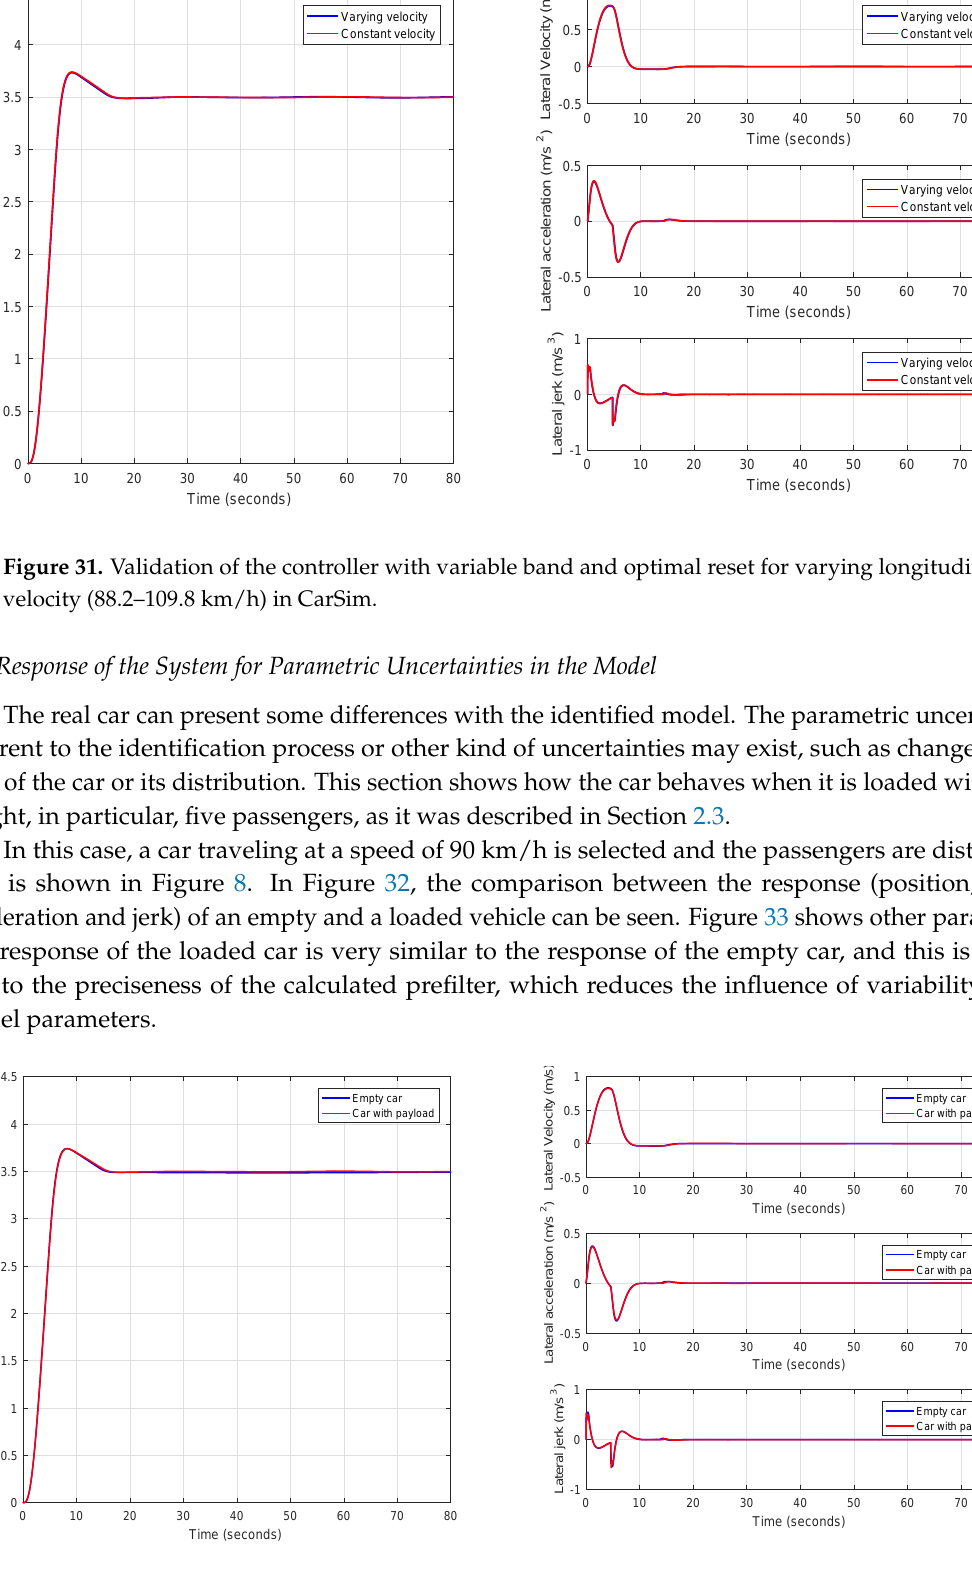
Figure 32. Validation of the controller with variable band and optimal reset with payload at 90 km/h in